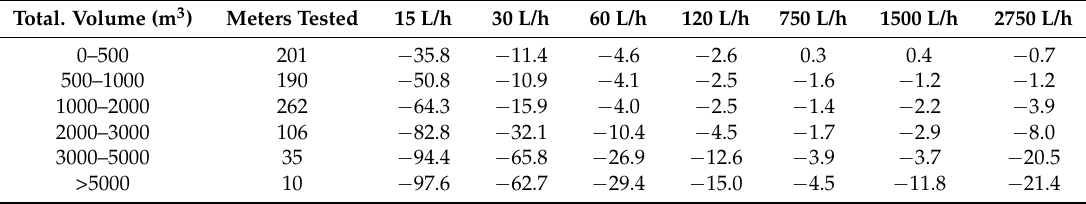
Table 6. The average error of indication (%) of meter type M_2 classified by totalised